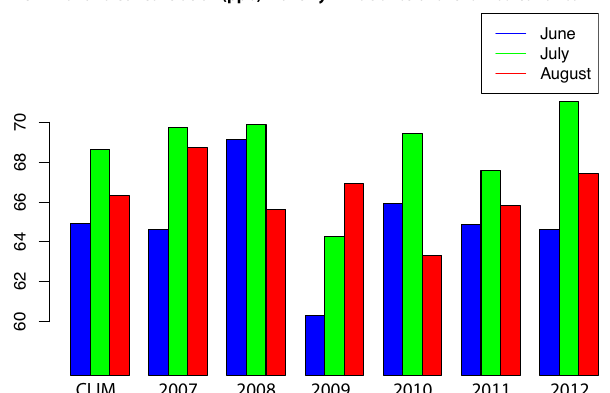
Figure 5. Monthly means of 3km ozone concentrations (ppb) mea- sured by IASI during the summertime period between 2007 and 2012 over the Mediterranean (IASI morning overpasses). Only the observations over the sea are considered in the averages. The monthly means referred to as “CLIM” represent the averages over the entire period